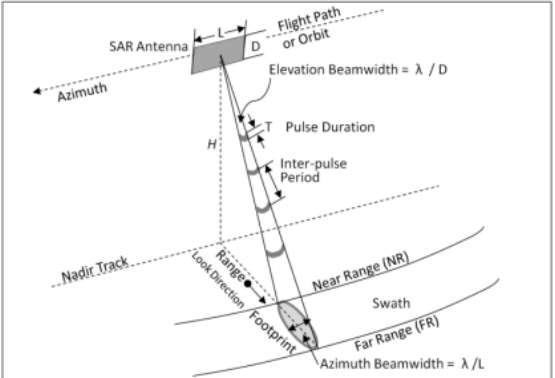
Figure 1. Scanning configuration of right-looking rectangular SAR antenna, modified after Olmsted (1993), to show antenna length (L), antenna width (D), and pulse duration (T).